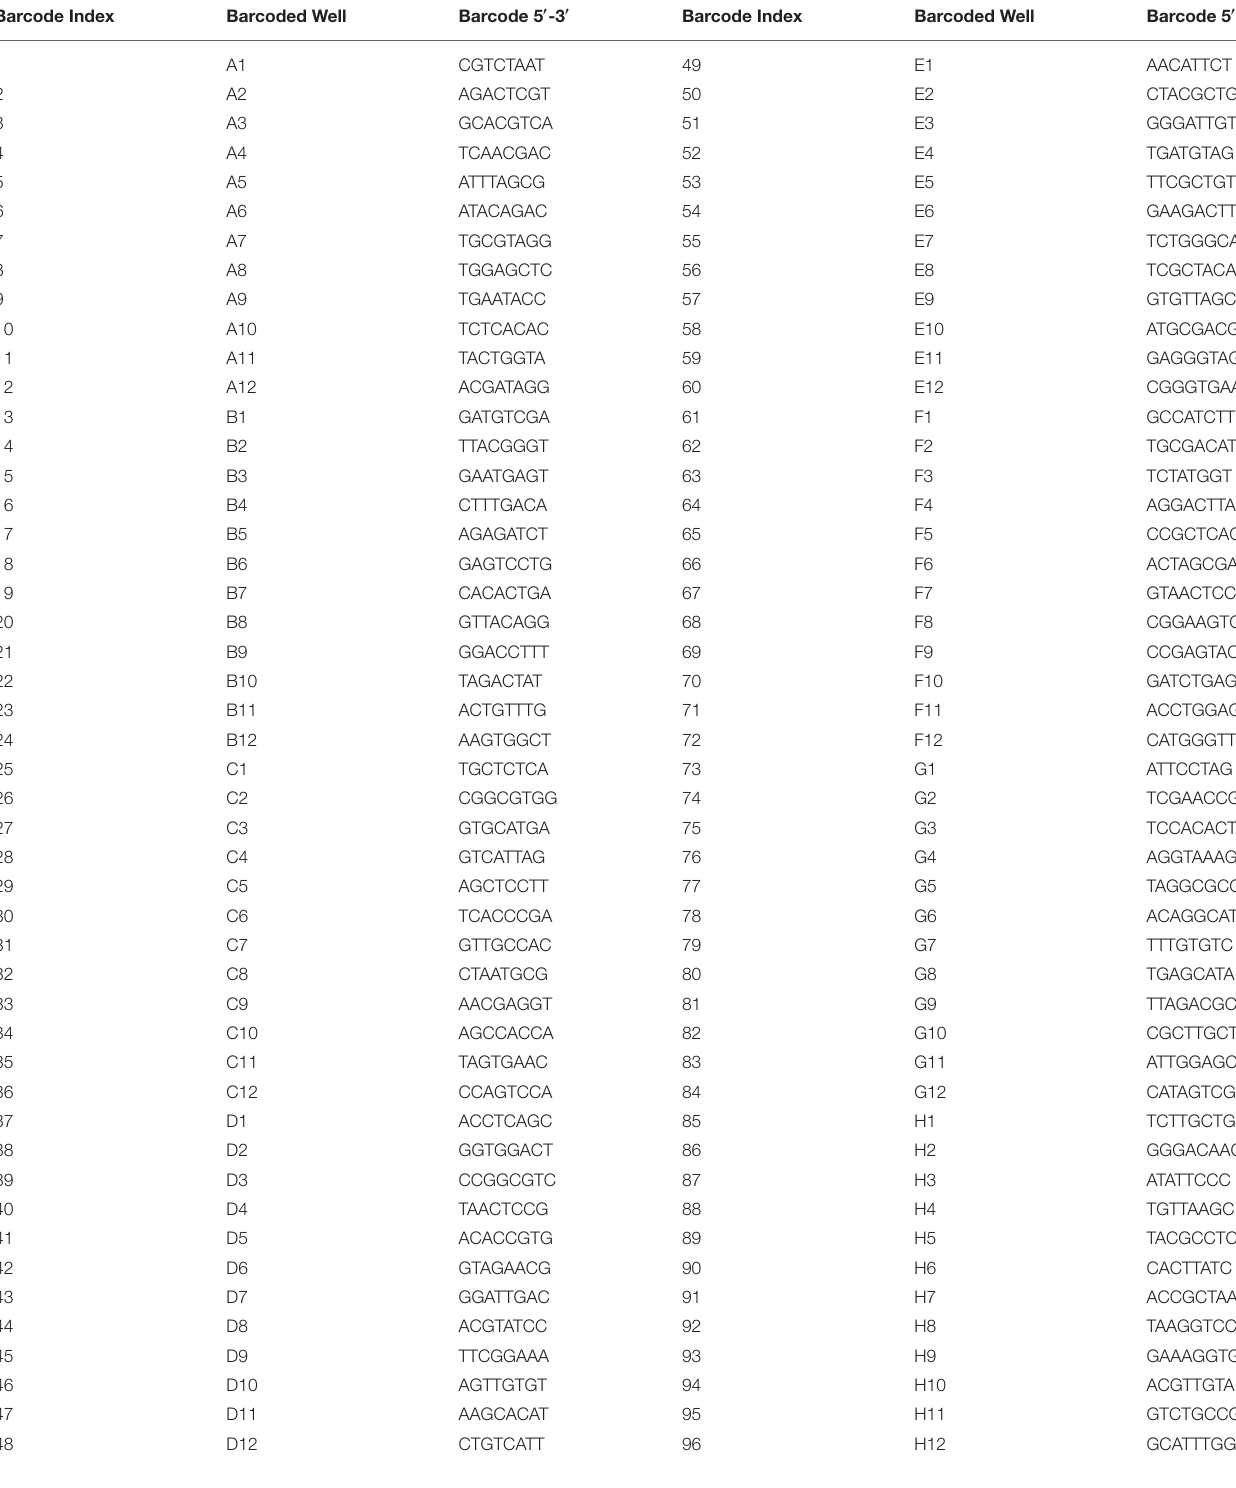
TABLE S4 | List of well-specific barcodes used in TSO_BCx_UMI5_TATA